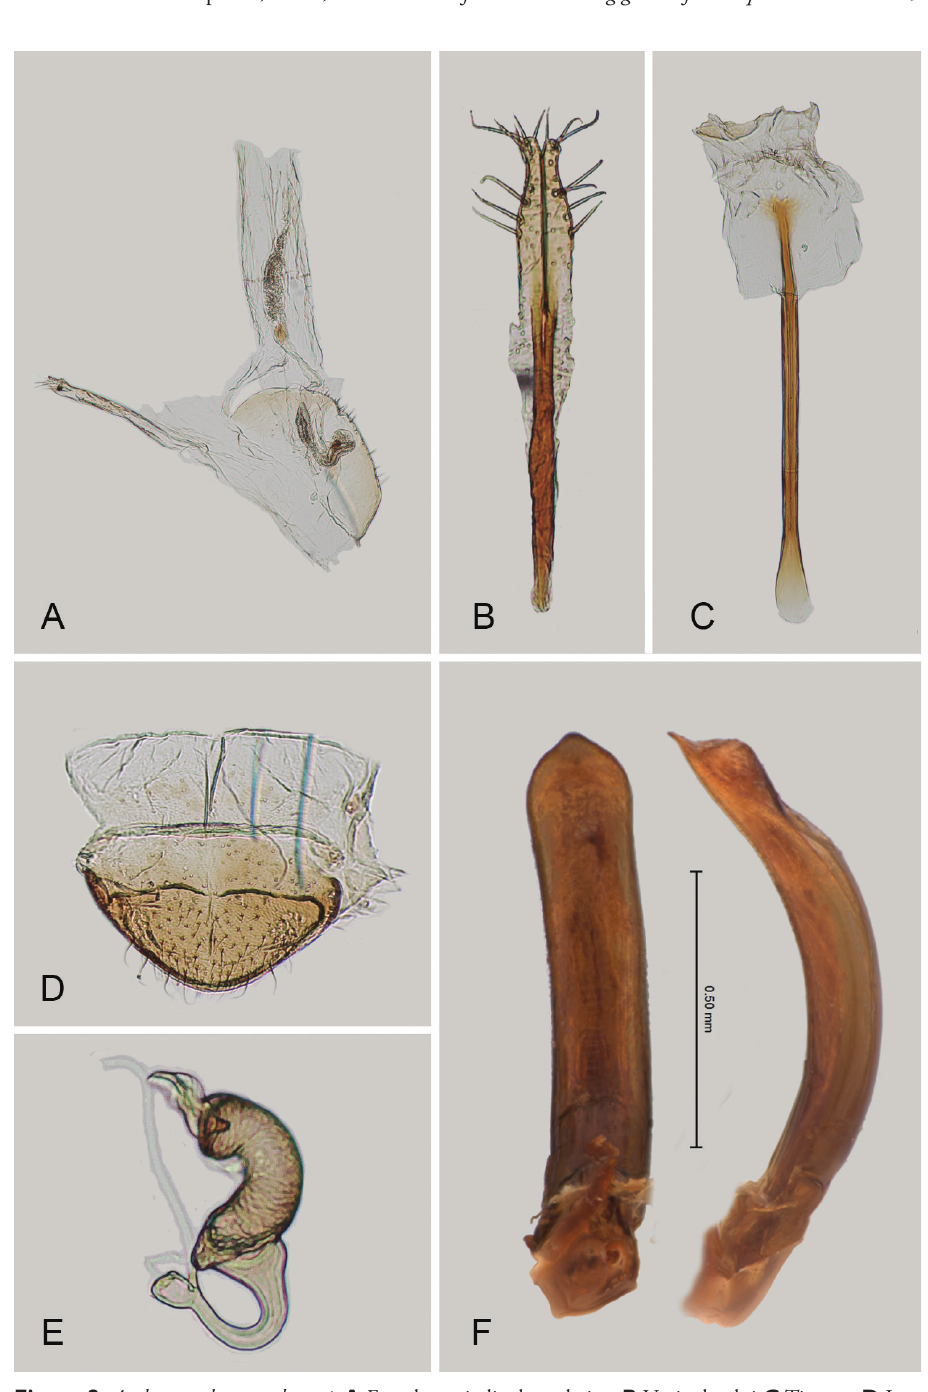
Figure 2. Andersonoplatus andersoni . A Female genitalia, lateral view B Vaginal palpi C Tignum D Last abdominal tergite of female E Spermatheca F Median lobe of aedeagus, ventral and lateral